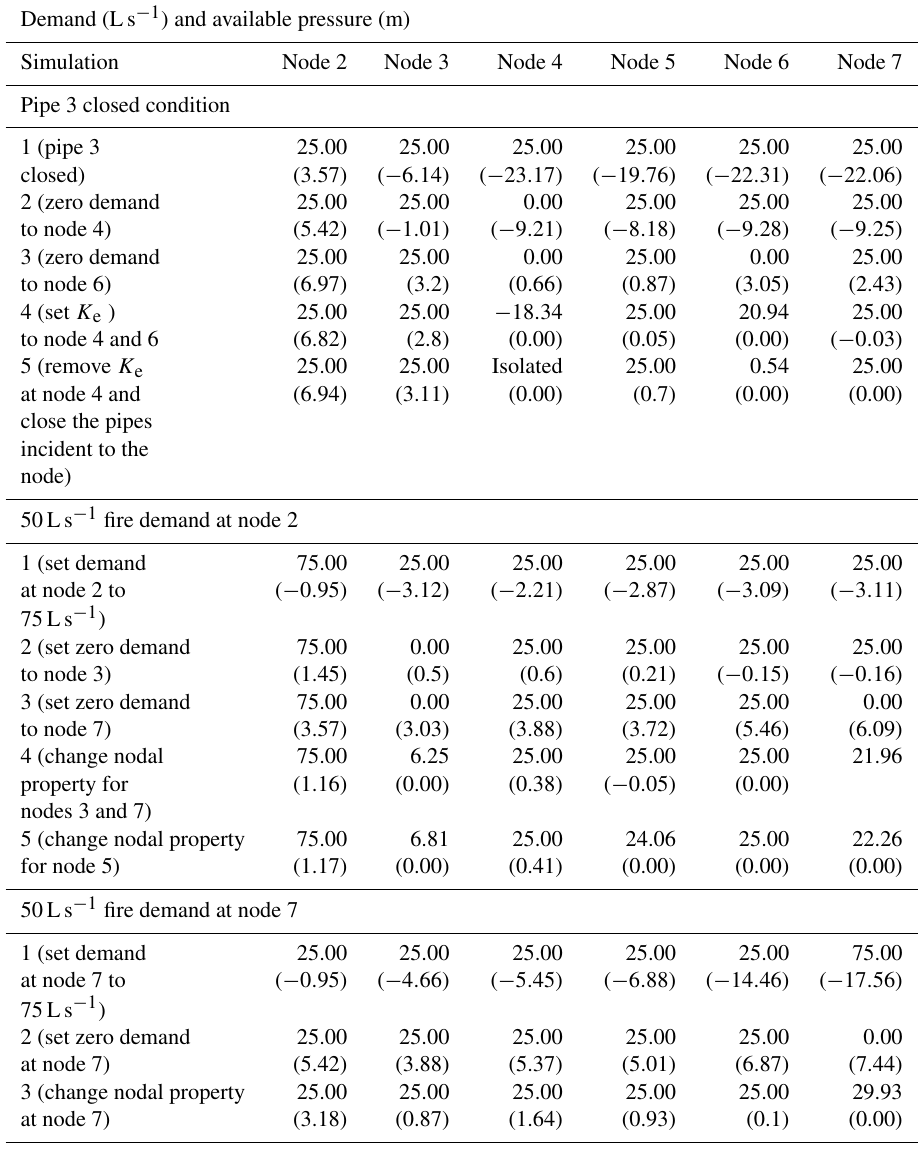
Table 3. Step-by-step analysis results showing nodal outflows and pressure at each level of simulation. Bracketed values denote available pressure in